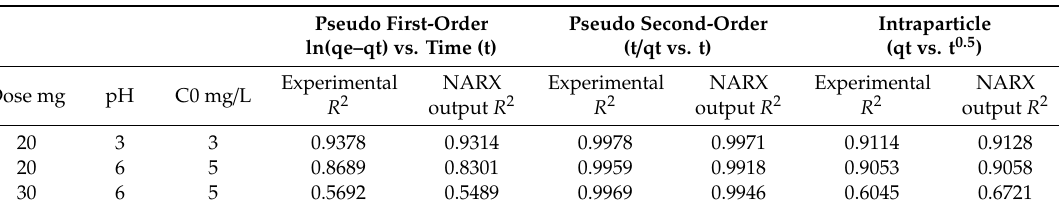
Table 1. Adsorption kinetics and correlation coe ffi cients.